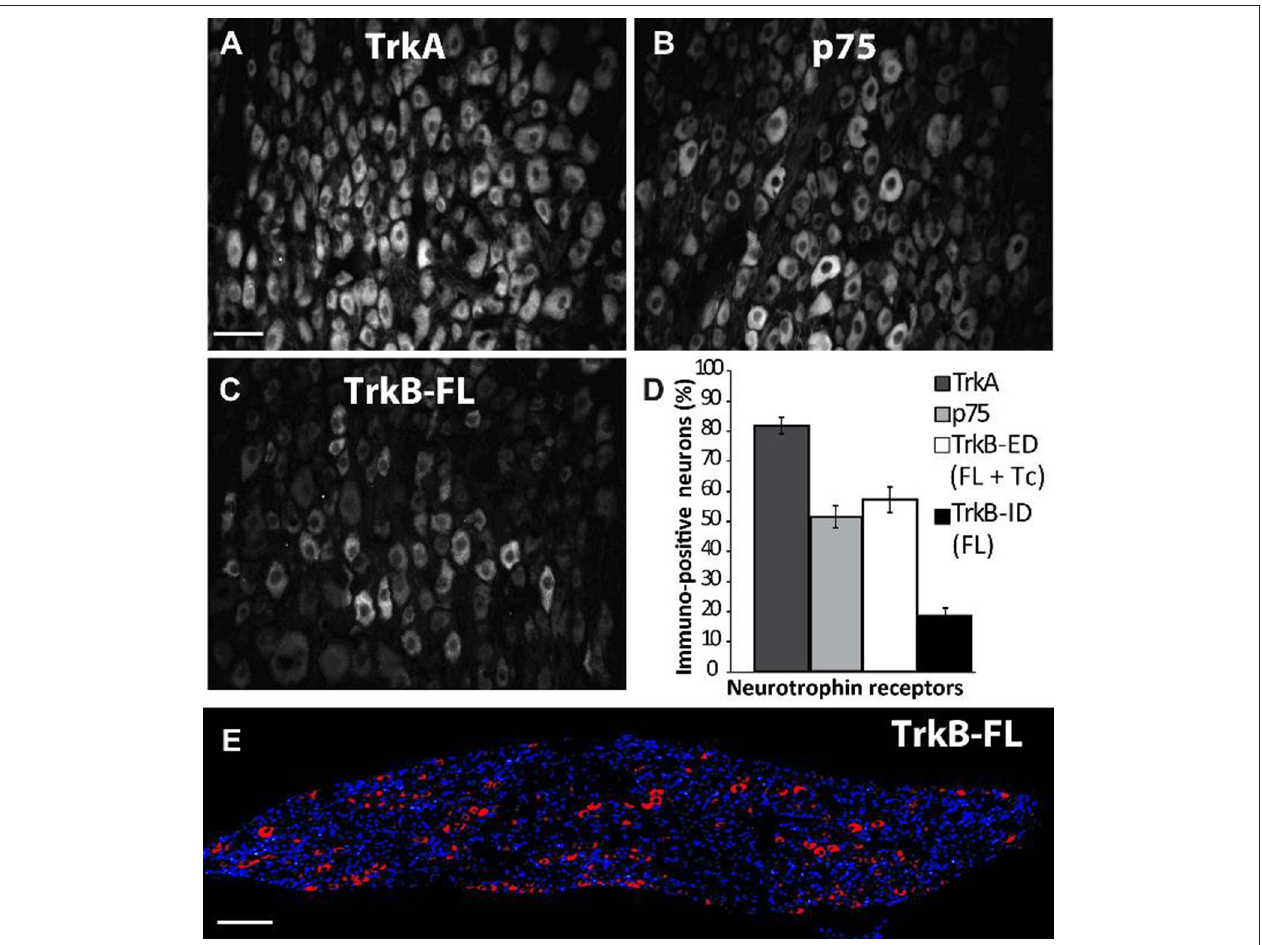
FIGURE 1 | Differential expression of TrkA, p75NTR, and TrkB in rat superior cervical ganglion (SCG). Examples of sympathetic neurons from adult SCG which were immunolabeled against TrkA (A) , p75NTR (B) , and TrkB-Fl (C,E) . Sampling across the entire SCG resulted in different proportions (%) of immunopositive neurons for neurotrophin receptors (D) : 83% of the total neuronal population expressed TrkA while 52% expressed p75NTR. An antibody specific for Trk-Fl (that recognizes an intracellular domain) labeled 19% of ganglionic neurons (C,E) , whereas another antibody directed against an extracellular domain (ED) common for both TrkB isoforms, full (Fl) and truncated (Tc), stained 55% of neurons. Scale bar = 50 µ m (A–C) , n = 5. (E) A transversal slice of the SCG showing DAPI staining (blue) and TrkB-Fl expression (red) indicating that TrkB-Fl is evenly expressed in the SCG. Scale bar = 200 µ m.